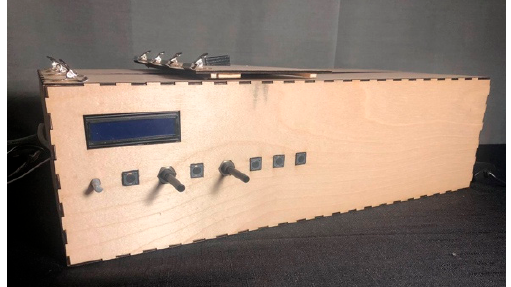
Figure 4. Testing machine: it makes a linear movement to stretch and release the sample. It is pos- sible to set the starting position, the speed and the length of the movement.